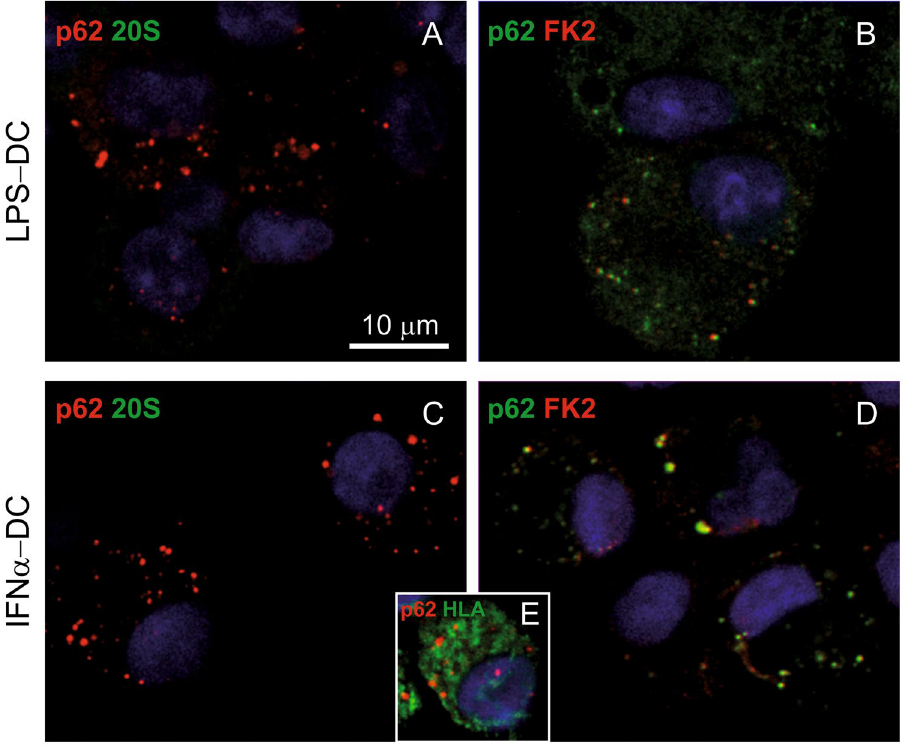
Figure 7. Confocal microscopy of DALIS in GM/LPS-DC and IFN-DC. ( A,B ) Cells treated with GM-CSF for 5 days and then with LPS for 7 h, cytospinned and processed following the common sample preparation for confocal microscopy procedure as in the case of Fig. 3A. Note in ( A ) the p62-immunostained cytoplasmic bodies (red), mostly corresponding to DALIS, and the lack of 20S (green) reactivity. ( B ) Cells show colocalization (yellow) of p62 (green) and FK2 (red) in many DALIS-type cytoplasmic bodies. ( C,D ) Cells incubated for 3 days with GM-CSF plus IFN α showed p62-reactive DALIS and lack of 20S-reactive PaCS ( C ), and colocalization of p62 (green) and FK2 (red) in DALIS ( D ). ( E ) IFN-DC showed partial colocalization (yellow) between p62 (red) and class II HLA